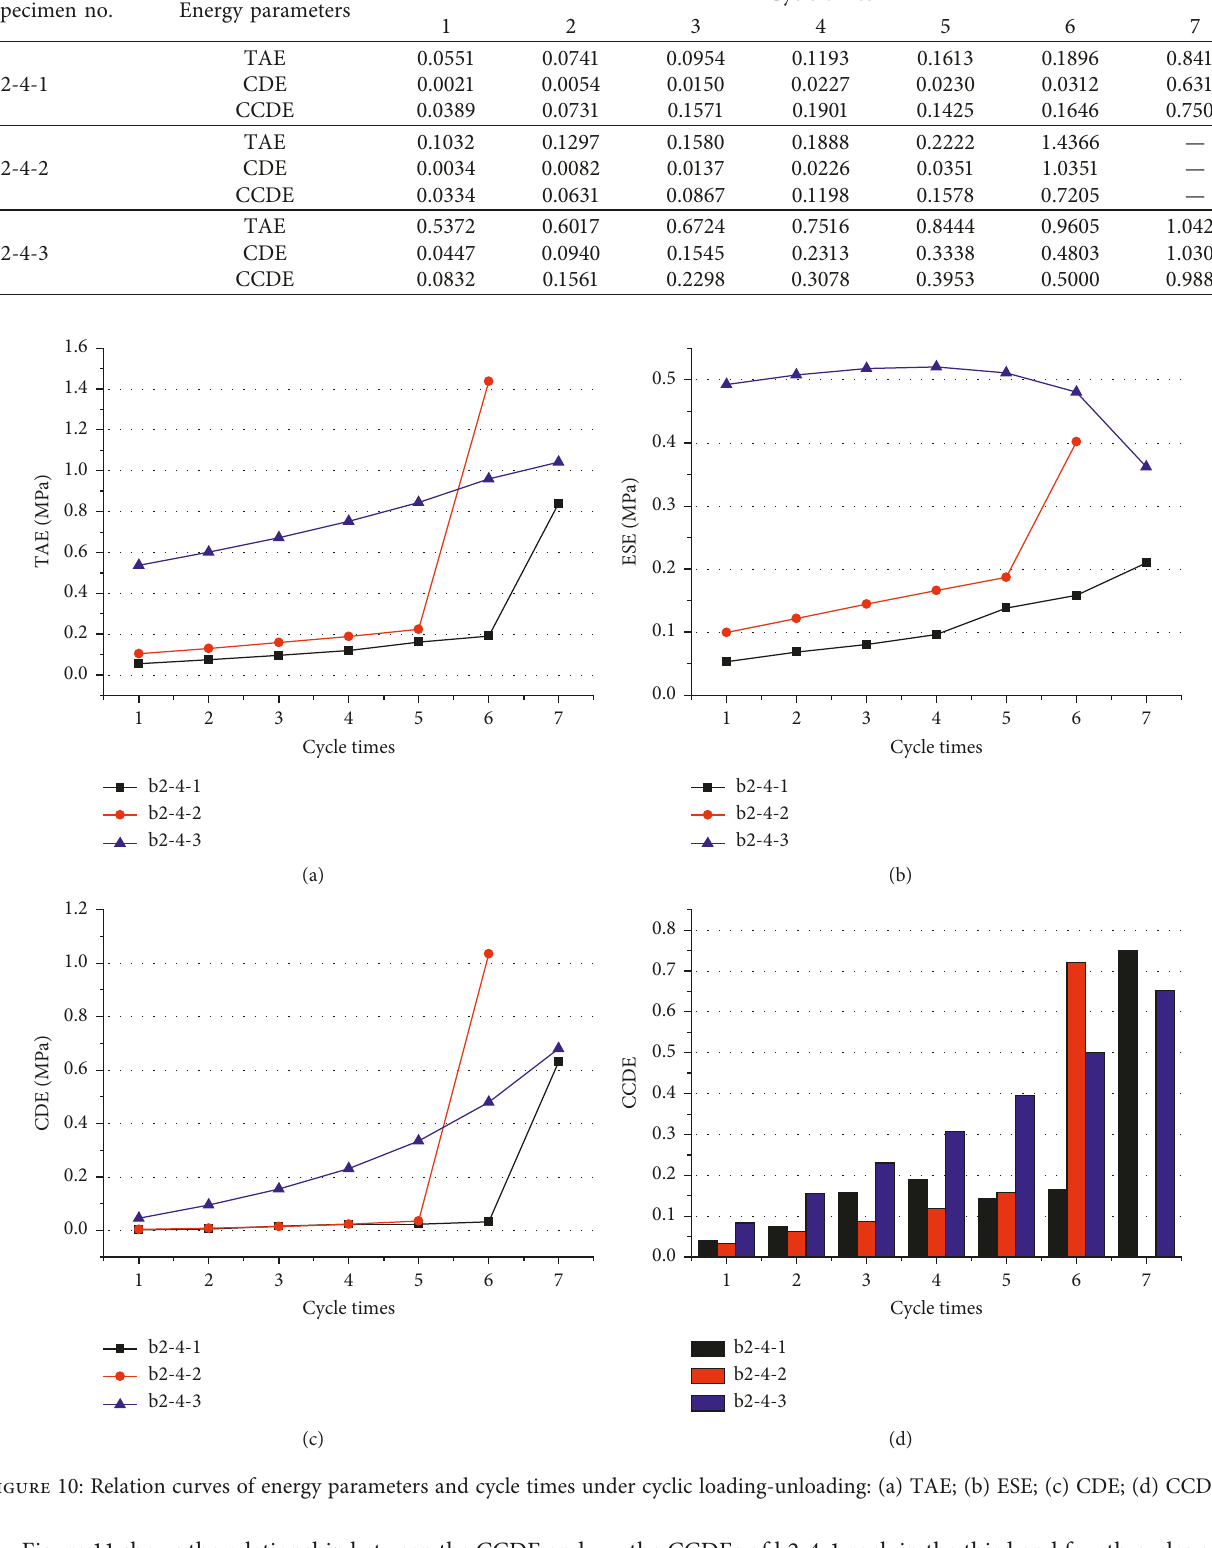
Table 7: Energy parameters of rocks under cyclic loading-unloading conditions. Specimen